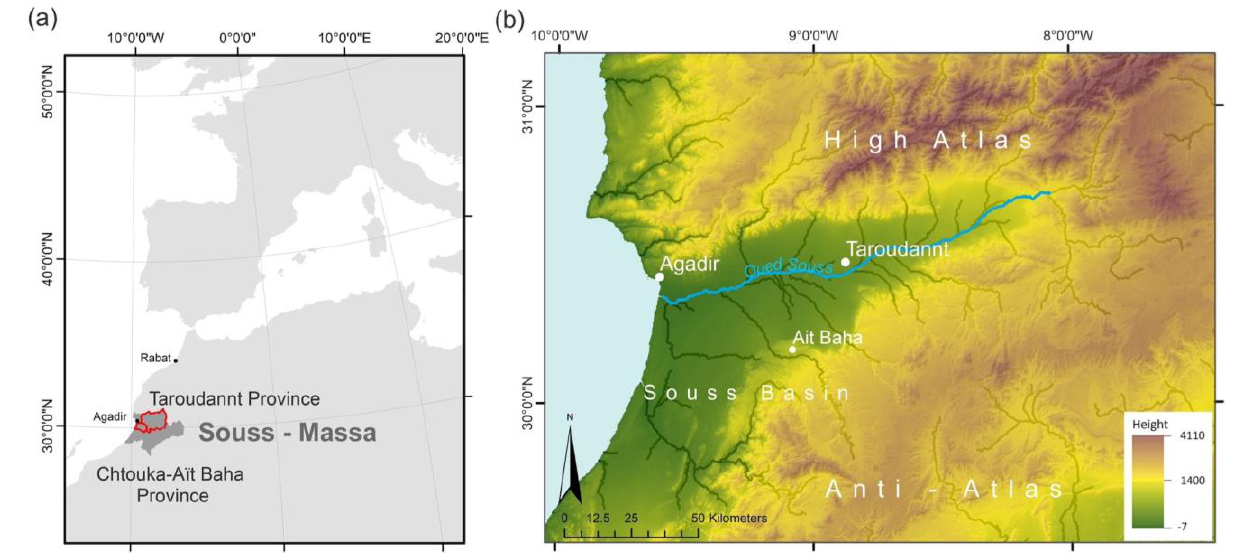
Figure 1. Location of study area (a) at provinces Taroudannt and Chtouka-Ait Baha and (b) in the Souss Basin.